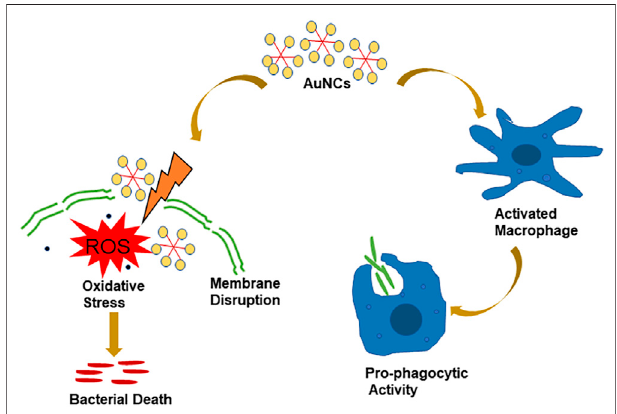
FIGURE 8 | Graphic illustration of the antibacterial and enhanced phagocytosis effect of